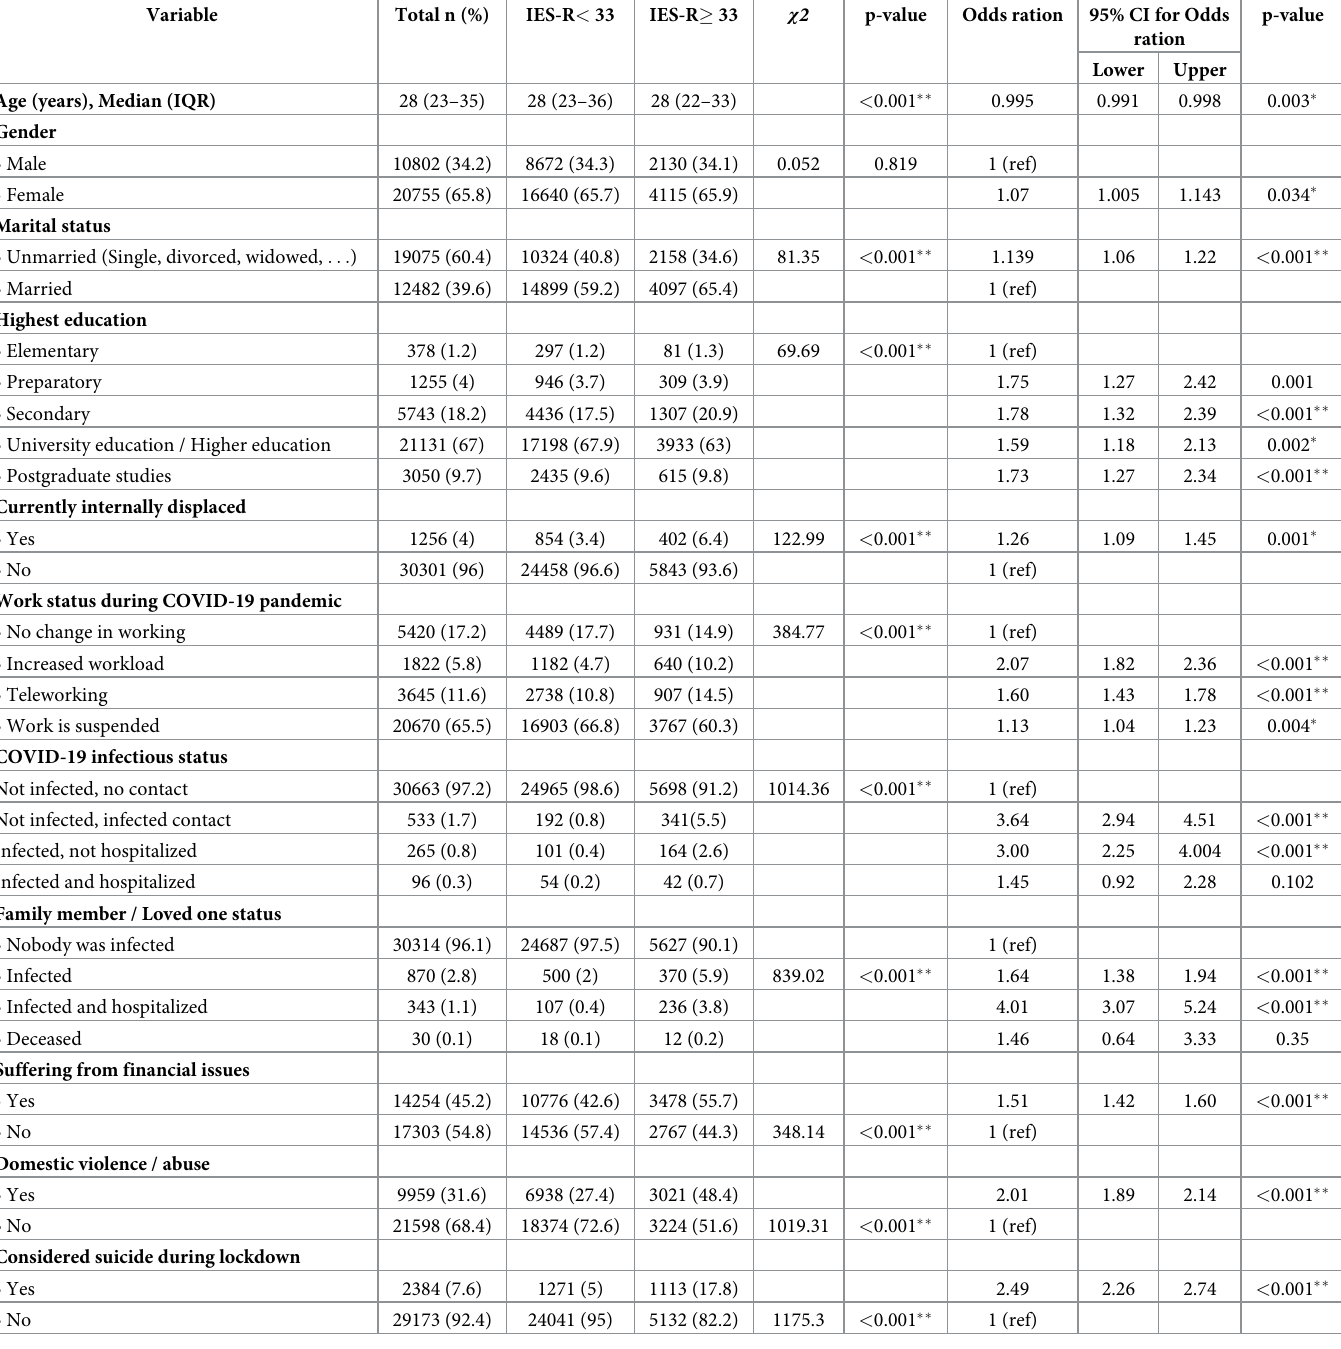
Table 5. Bivariate and multivariate binomial logistic regression analysis of post-traumatic stress disorder (ISE-R � 33).